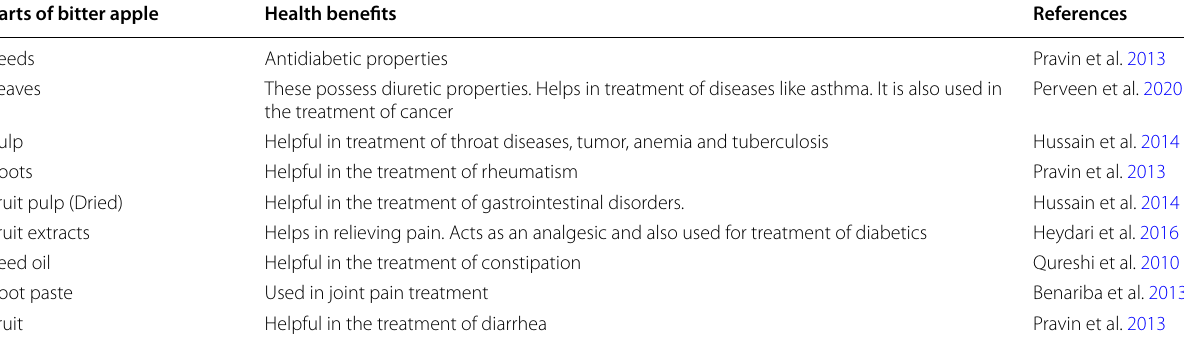
Table 3 Health benefits and traditional uses of the different parts of bitter apple Parts of bitter